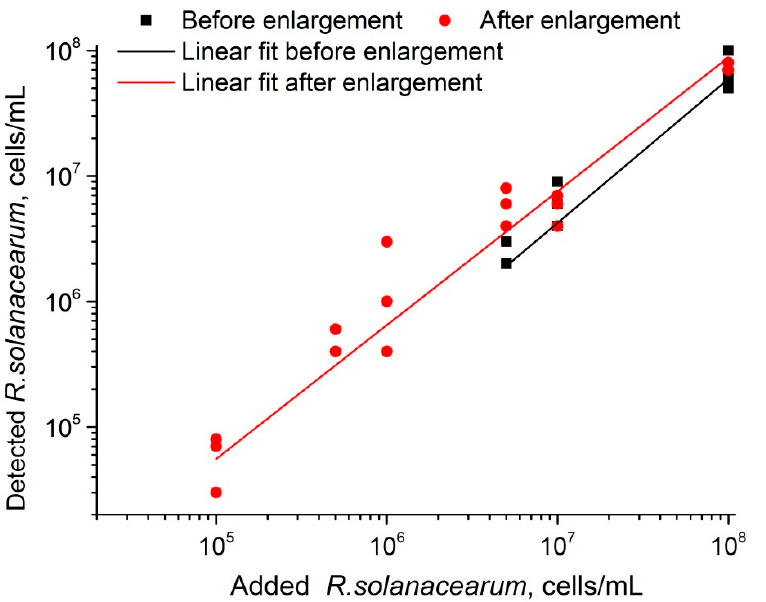
Figure 8. Correlation between added and detected R. solanacearum cells for LFIA before and after GNP enlargement.